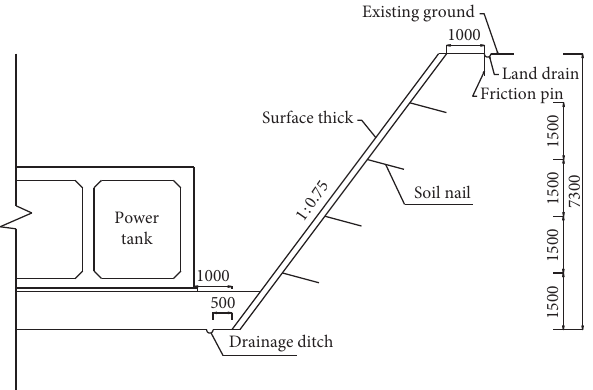
Figure 5: Schematic diagram of the right half of the foundation pit of the pipe gallery (unit: mm).